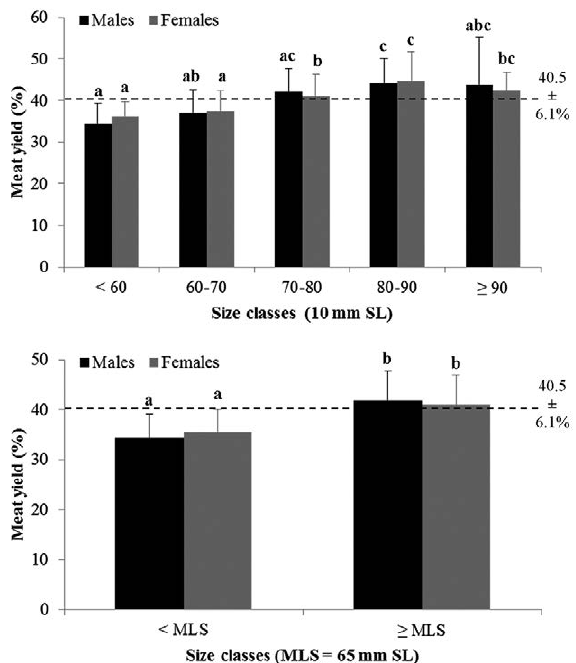
Fig. 4. – Average MY according to specimen size (individuals grouped into 10 mm SL classes) and as a function of the MLS=65 mm SL established for Bolinus brandaris . Interrupted lines denote average MY (mean±SD). In each sex, different superscript letters denote statistically significant differences (p<0.05) in MY between size classes.